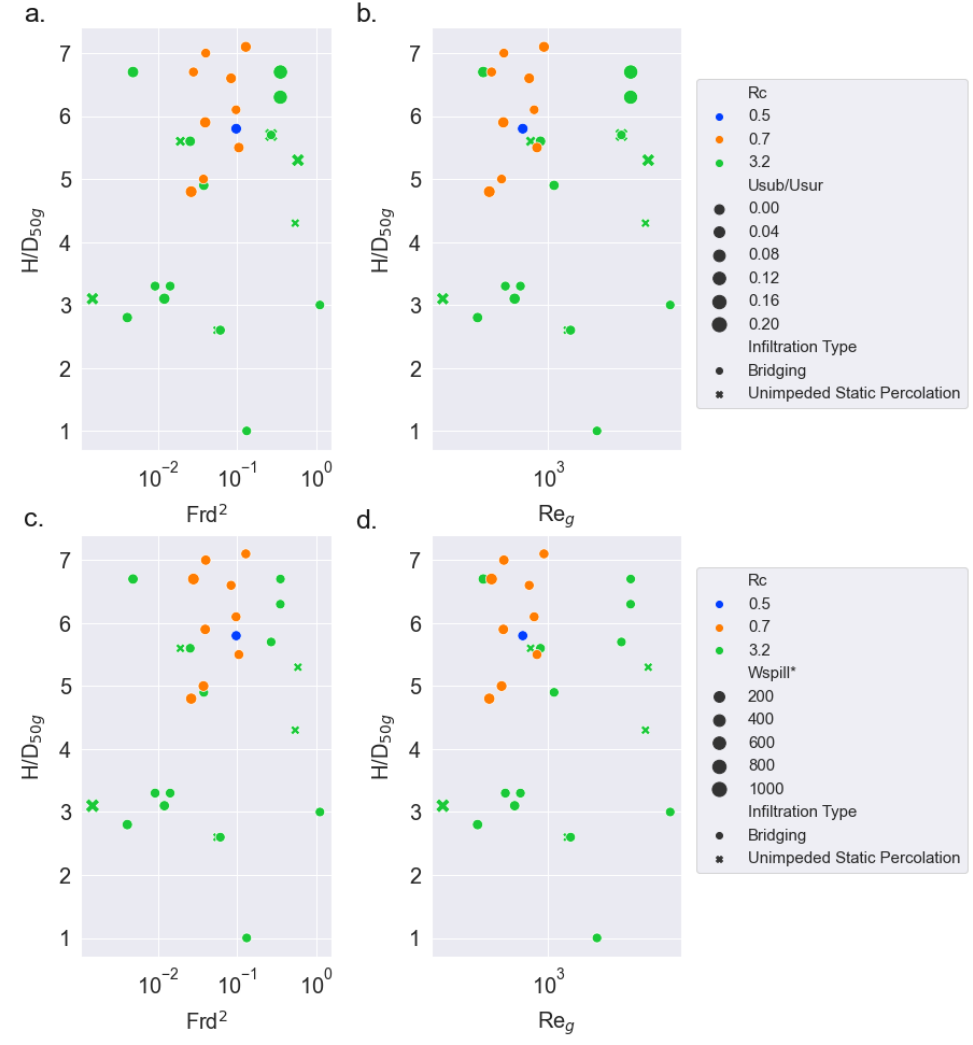
Figure 6. Infiltration dimensionless depth of fine material and type of fine particles into the substrate as a function of R c , W spill ∗ and ( a , c ) densimetric Froude number squared of the particles, ( b , d ) Particle Reynolds number of the